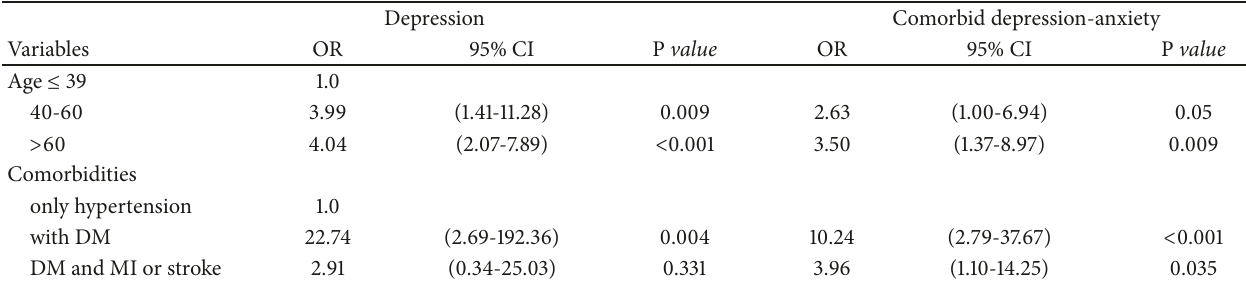
Table 4: Associated factors with depression and comorbidity of depression and anxiety among hypertensive